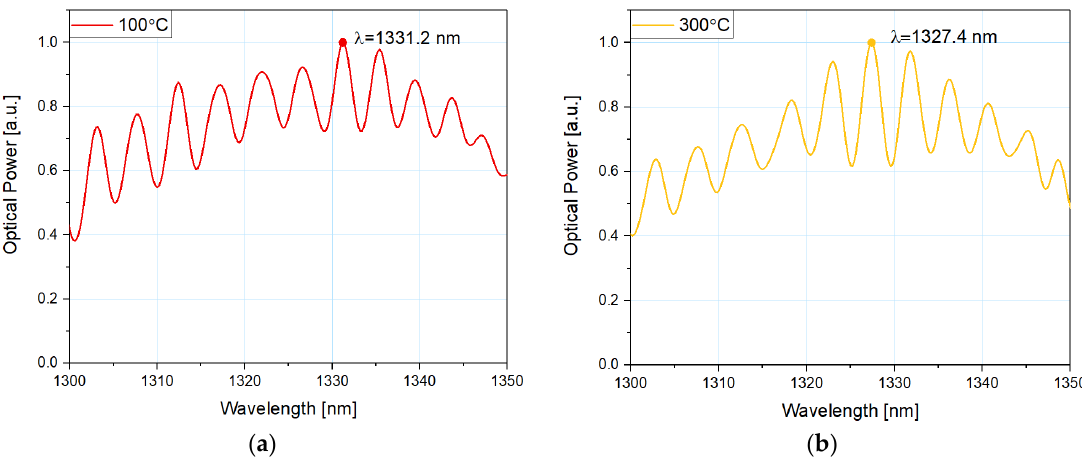
Figure 4. Normalized measured response of the reflected signal for the microsphere-based sensor with 100 nm ZnO ALD coating at ( a ) 100 ◦ C and ( b ) 300 ◦